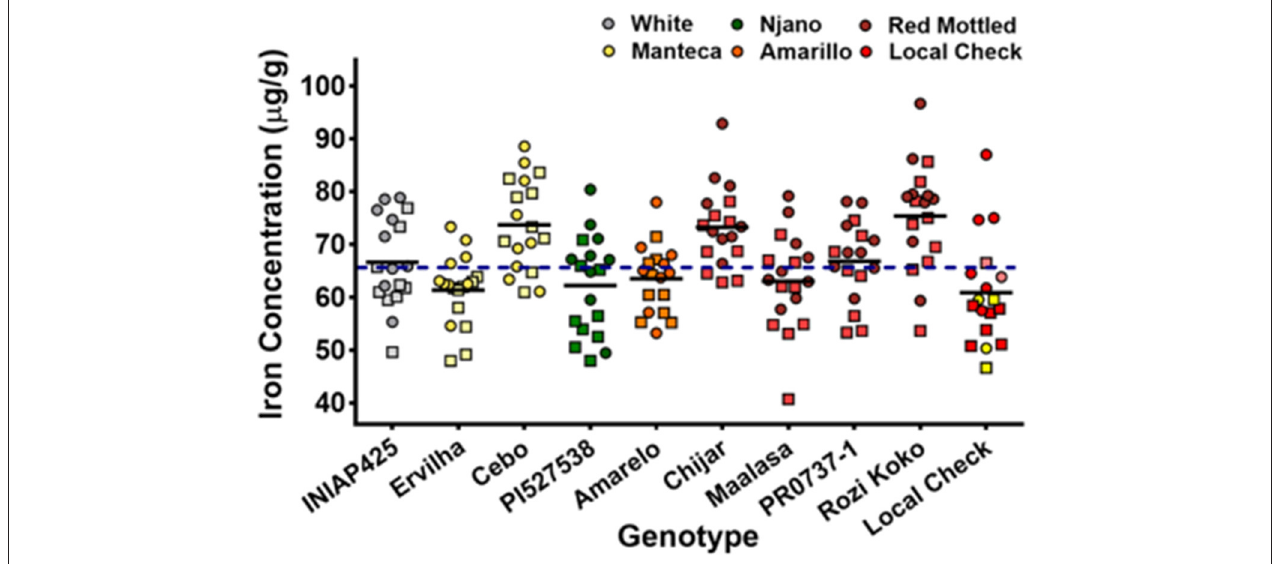
FIGURE 3 | Iron concentrations of genotypes grown in nine locations across three agro-ecological zones in Uganda, field season 2015 (squares) and 2016 (circles). Adapted from Katuuramu et al. (2021). Dashed line indicates mean Fe concentration of all values.